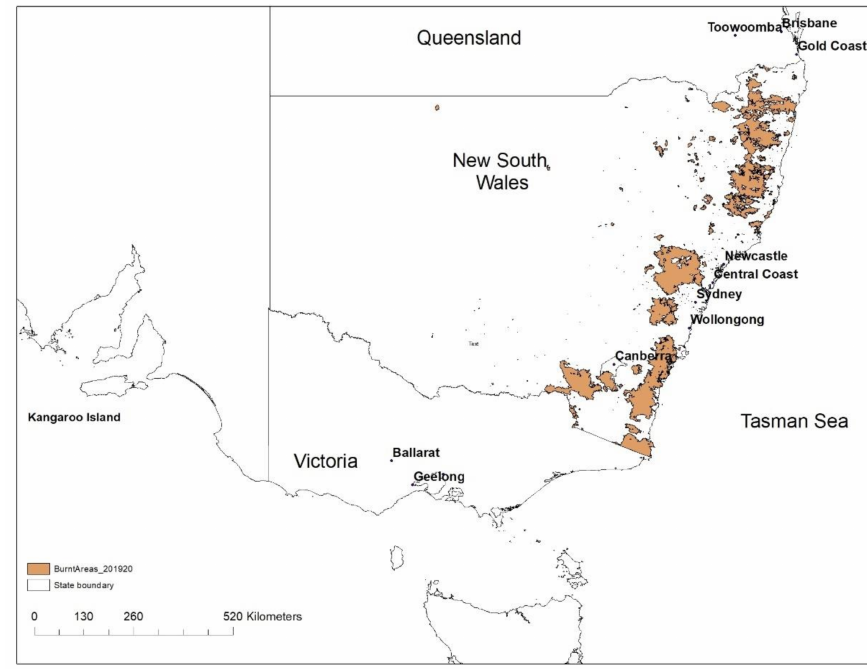
Figure 2. Total burned areas in NSW in the summer 2019–2020 bushfire event (Source: Department of Planning, Industry and Environment,